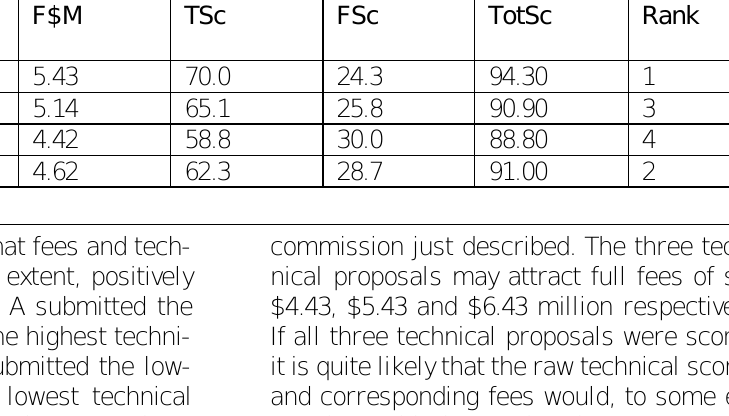
Table 1: Aggregating fee and technical score using Equation 2